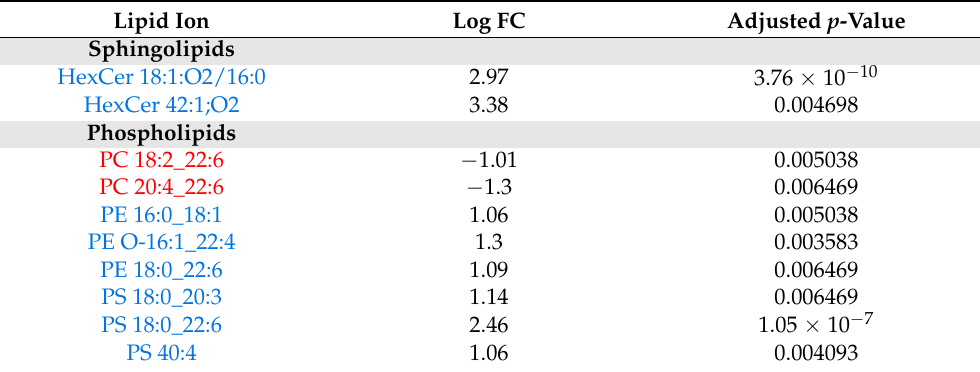
Table 2. Individual lipid molecules found at significantly different levels in Py vs. control. Ions elevated (dropped) in Py are coloured in blue (red). Log2 fold-change and adjusted p -values are listed (i.e., moderated t -test and FDR correction). Ions are grouped into sphingolipids and phospholipids and sorted alphabetically within each group.